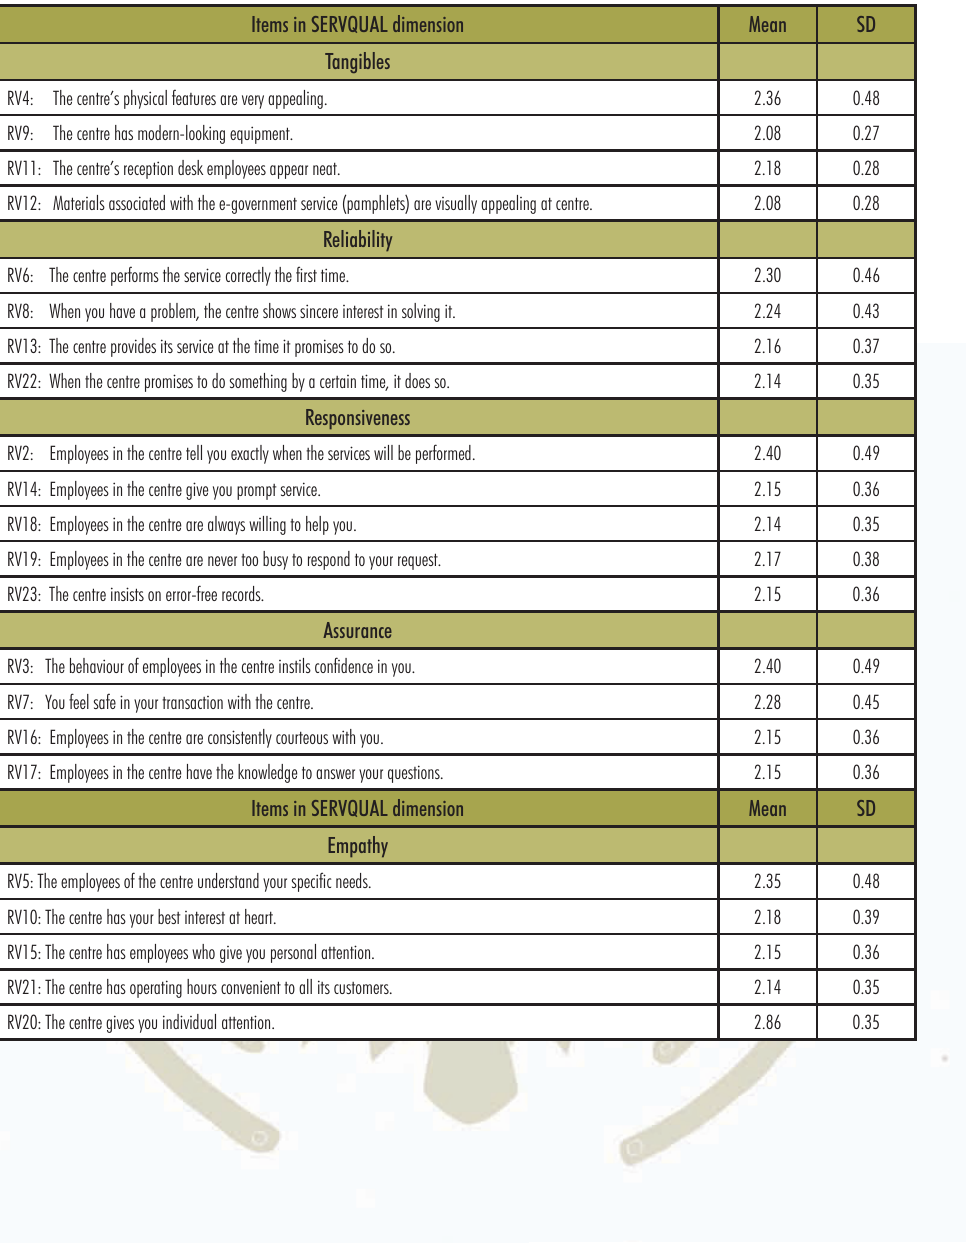
EXPERIENCE SCALE ITEM MEAN AND STANDARD DEVIATION (N = 168) Items in SERVQUAL dimension Mean SD